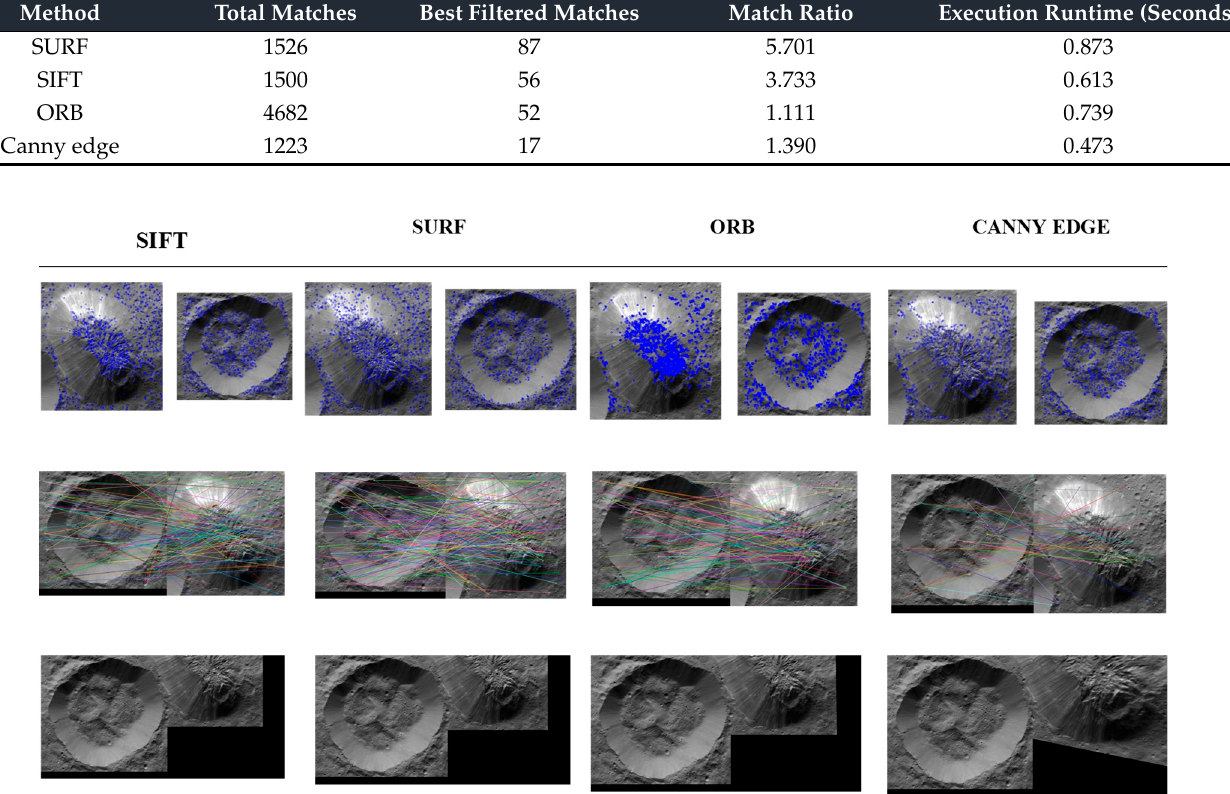
Figure 7. Comparative keypoint analysis ( top ), feature matching ( centre ), and image stitching ( bottom ) for best matched features for Ahuna Mons and Crater B using SIFT, SURF, ORB and Canny edge feature detection/computer vision models. Original images credit: NASA/JPL-Caltech/UCLA/MPS/DLR/IDA (130–140 m/px).